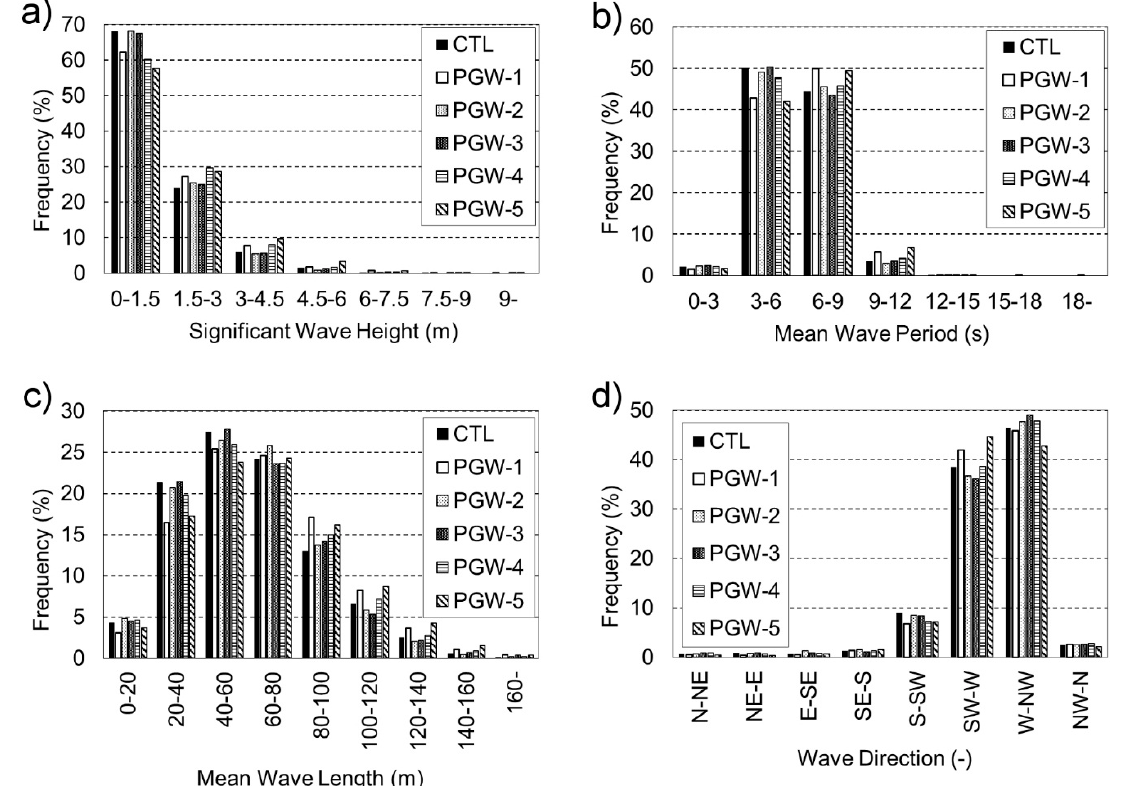
Figure 12. Frequency distribution of wave characteristics at Akita. ( a ) H s , ( b ) T m , ( c ) mean wavelength, and ( d ) wave direction. Frequencies are shown in %.